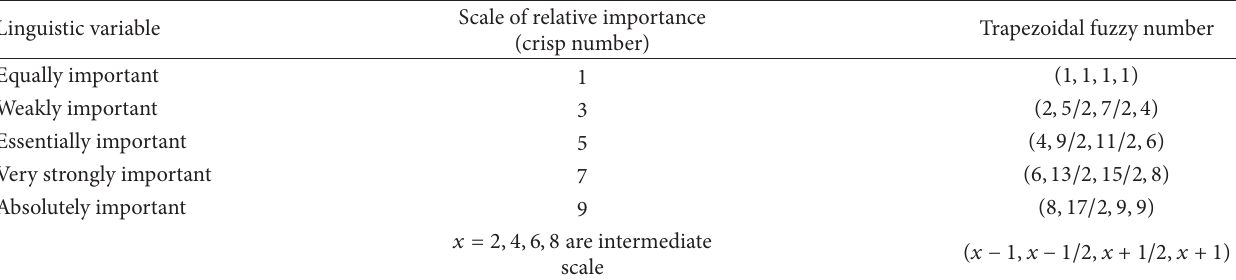
Table 1: Scale of relative importance used in the pairwise comparison of